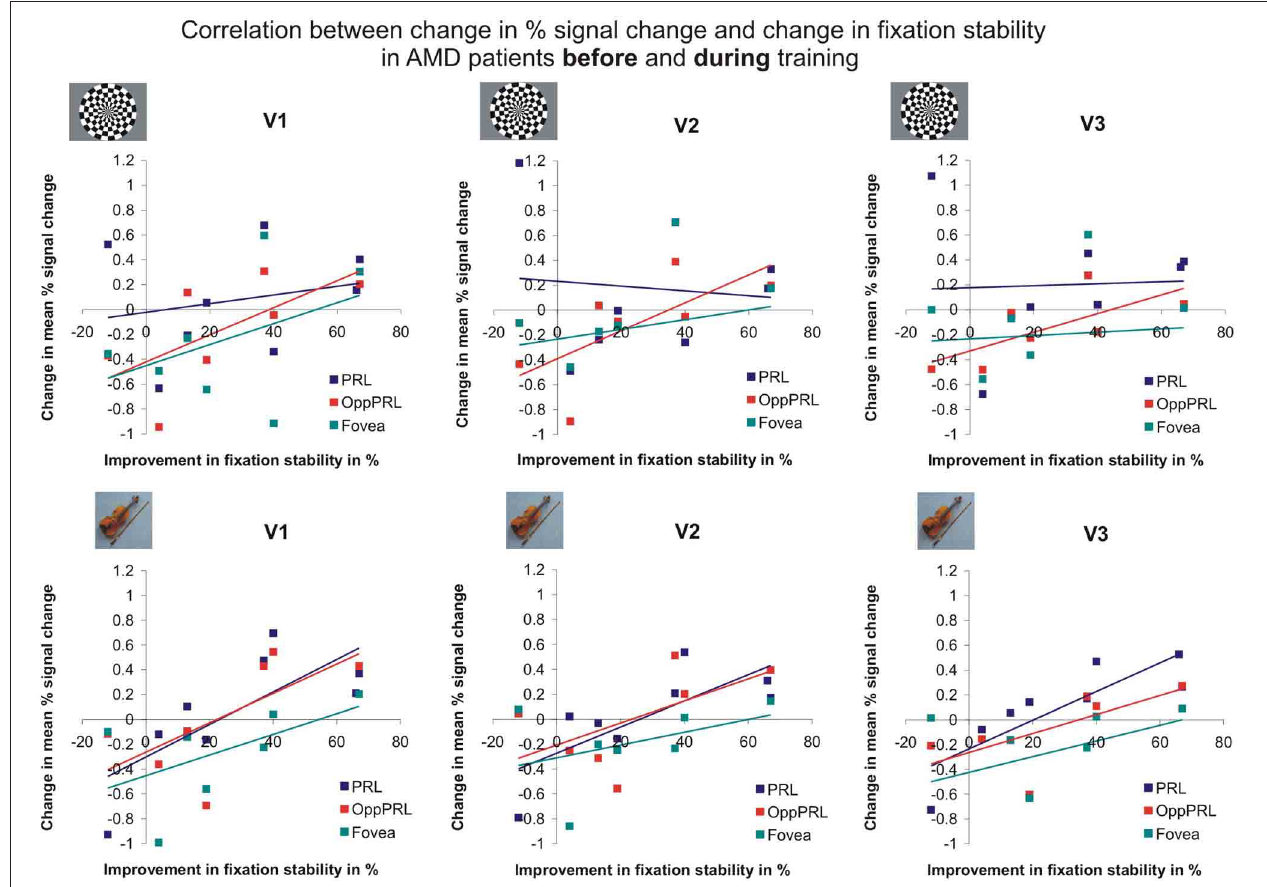
FIGURE 8 | Correlation between the change in % signal change and change in fixation stability, for the patient group only, before fixation training and during fixation training in individually mapped primary (V1), secondary (V2), and tertiary (V3) visual cortex. The upper row depicts the correlation between changes in